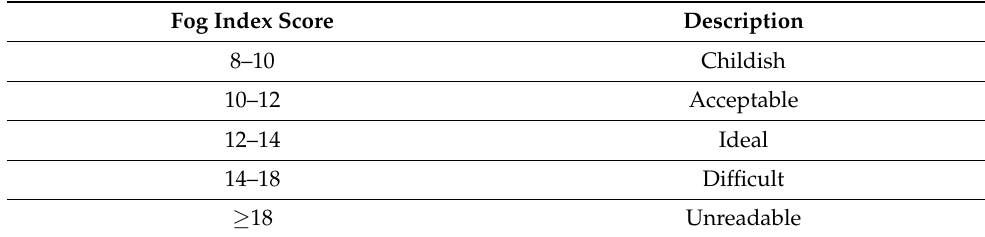
Table 1. Fog Index Score and Description.